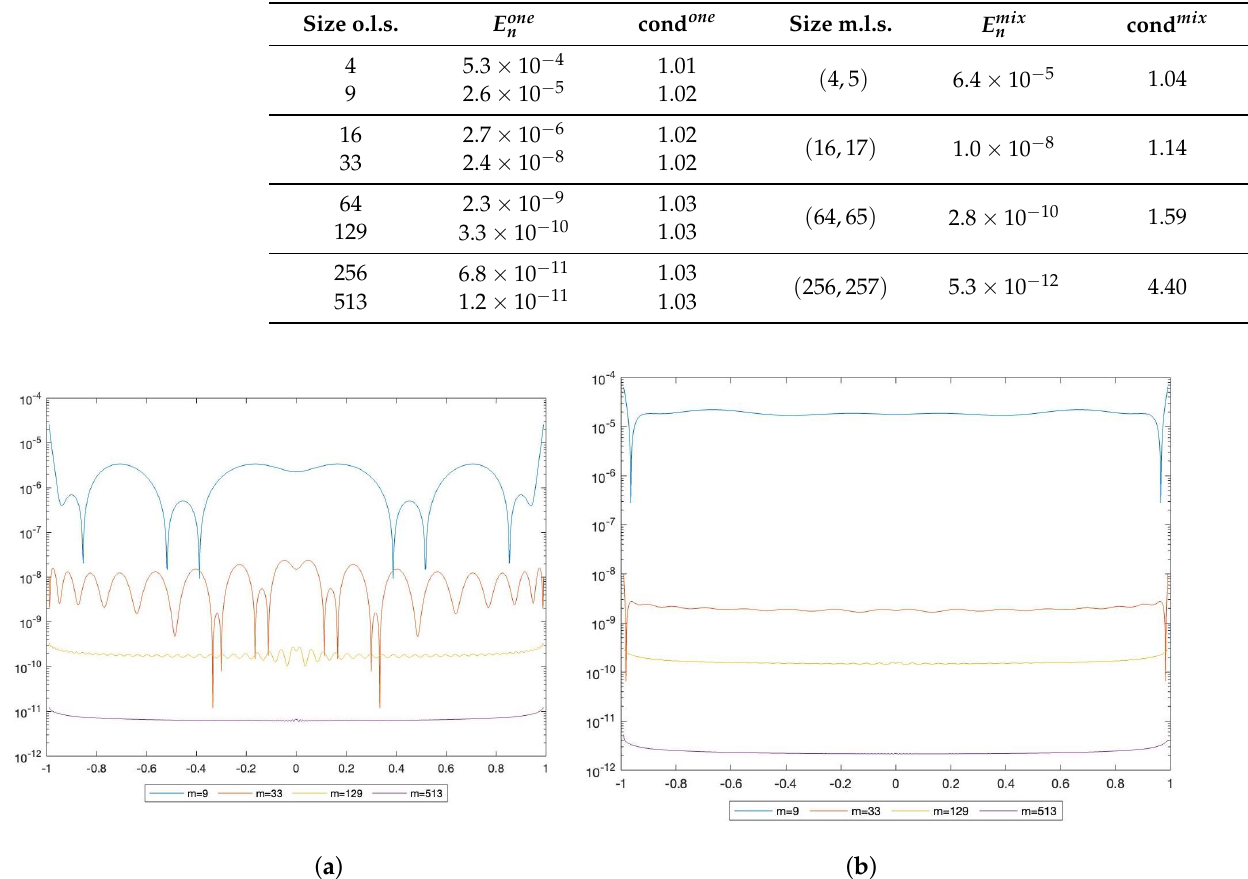
Table 1. Example 1.